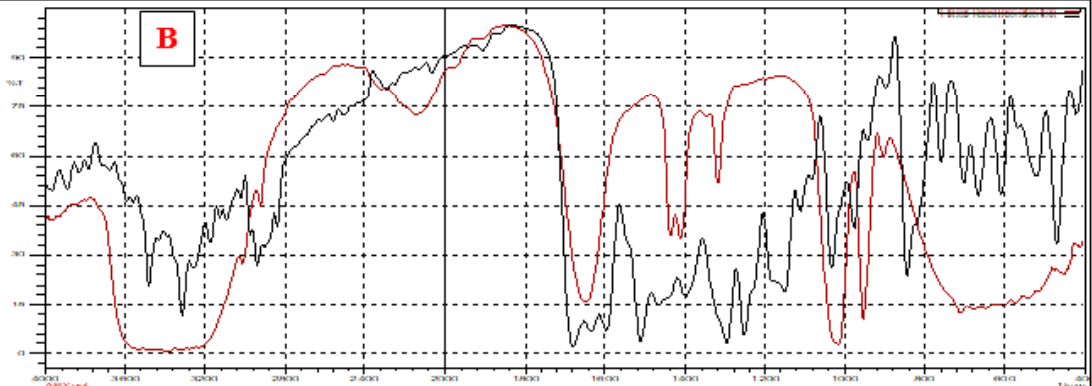
Figure 2. Comparative FTIR spectra of pure APX in black color with the red spectra of (A) APX-NE and (B) APX-NE based gel.